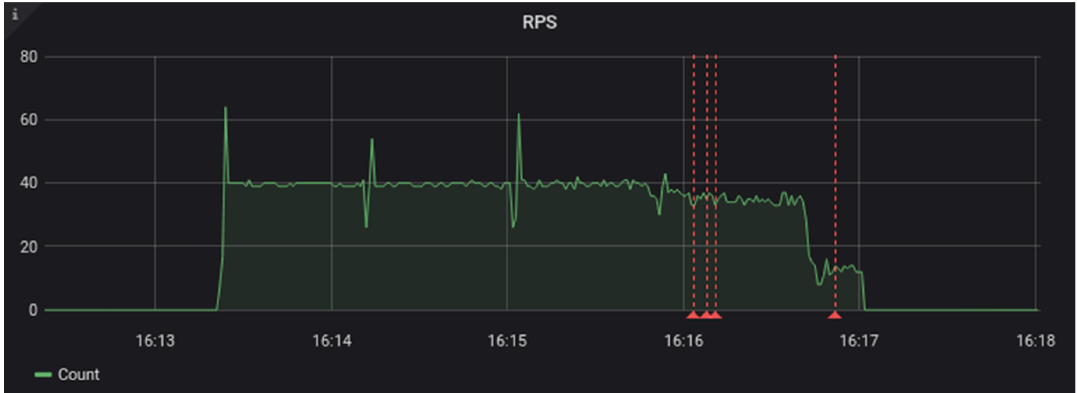
Figure 2. Fedora file system begins to show error responses at 40 requests per second.